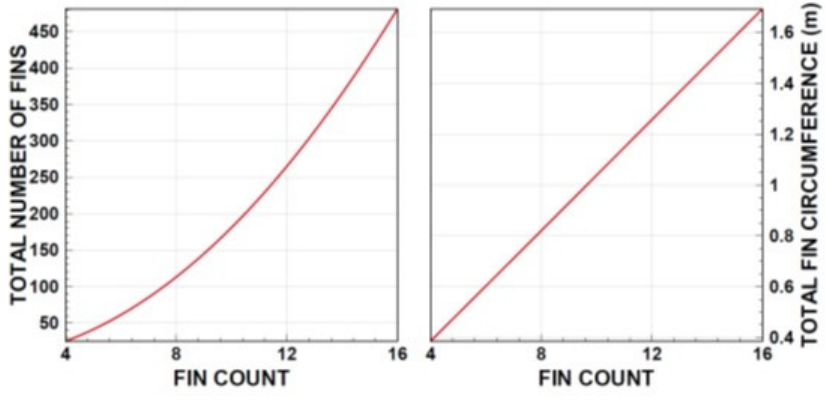
Figure 8. Variation of total number of fin and total fin circumference with fin count.